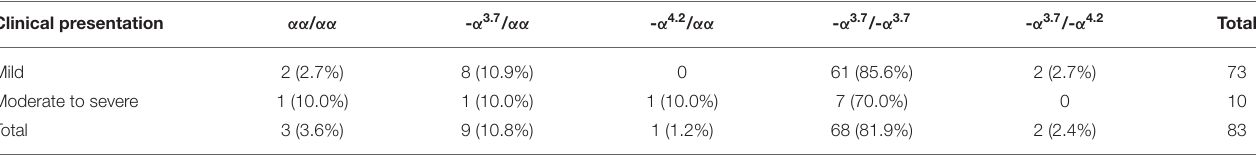
TABLE 5 | α -genotype among the affected babies. Clinical